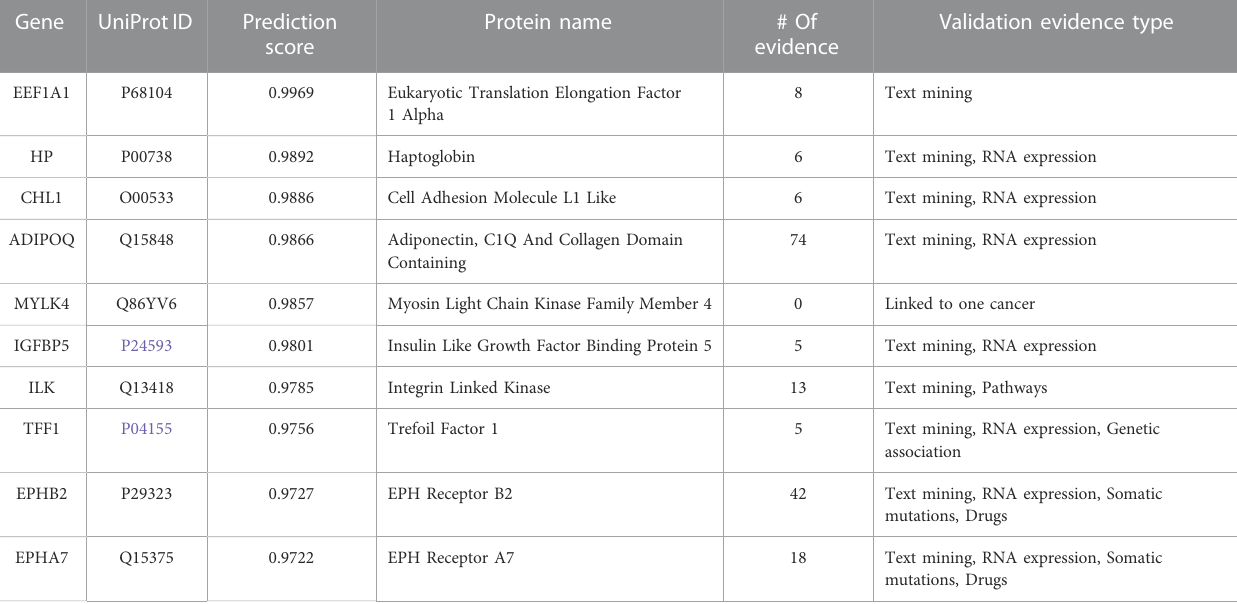
TABLE 6 Top 10-ranked novel predicted therapeutic targets based on the prediction score for colon cancer with the number and type of evidence linking the targets and disease. Gene UniProt ID